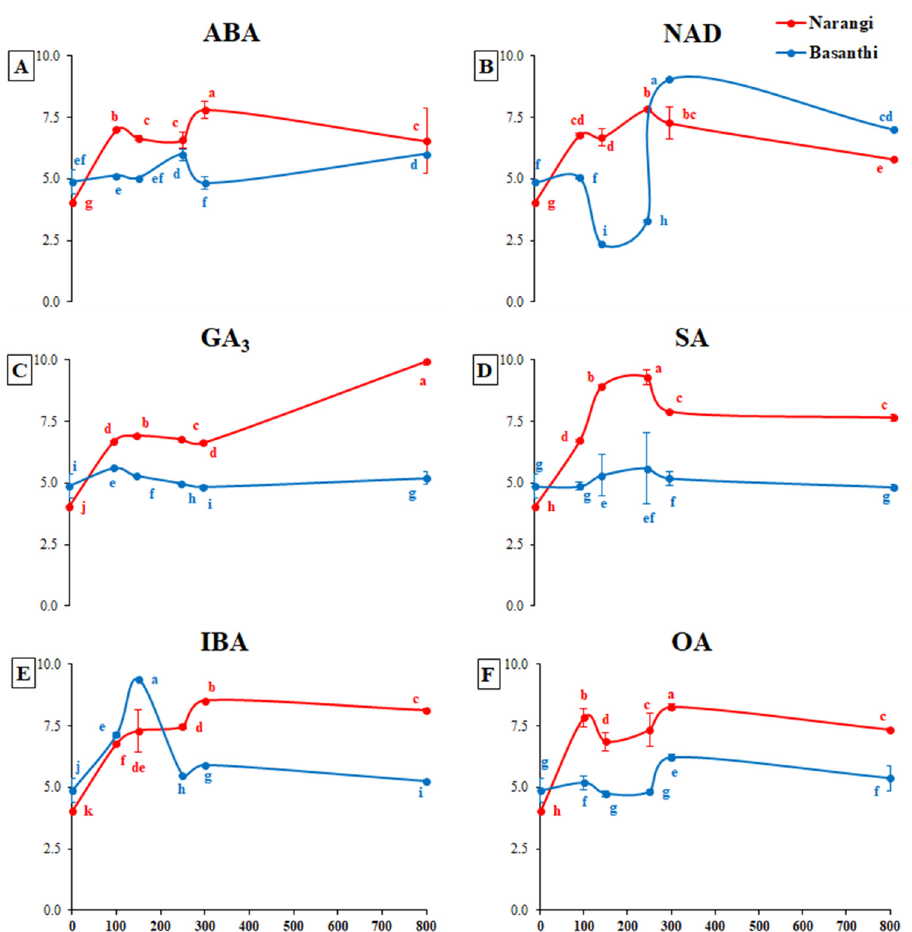
Figure 3. Flower fresh weight (g) of two cultivars of marigold (“Pusa Narangi Gainda” and “Pusa Basanthi Gainda”) as affected by different doses (mg ∙ L − 1 ) of ABA ( A ); NAD ( B ); GA 3 ( C ); SA ( D ); IBA ( E ) and OA ( F ). Same letters indicate non ‐ significant difference among treatments under Fisher’s least significant difference test ( p ≤ 0.05). Vertical bars indicate average ± standard error (three replications, under bi-factorial CRD).